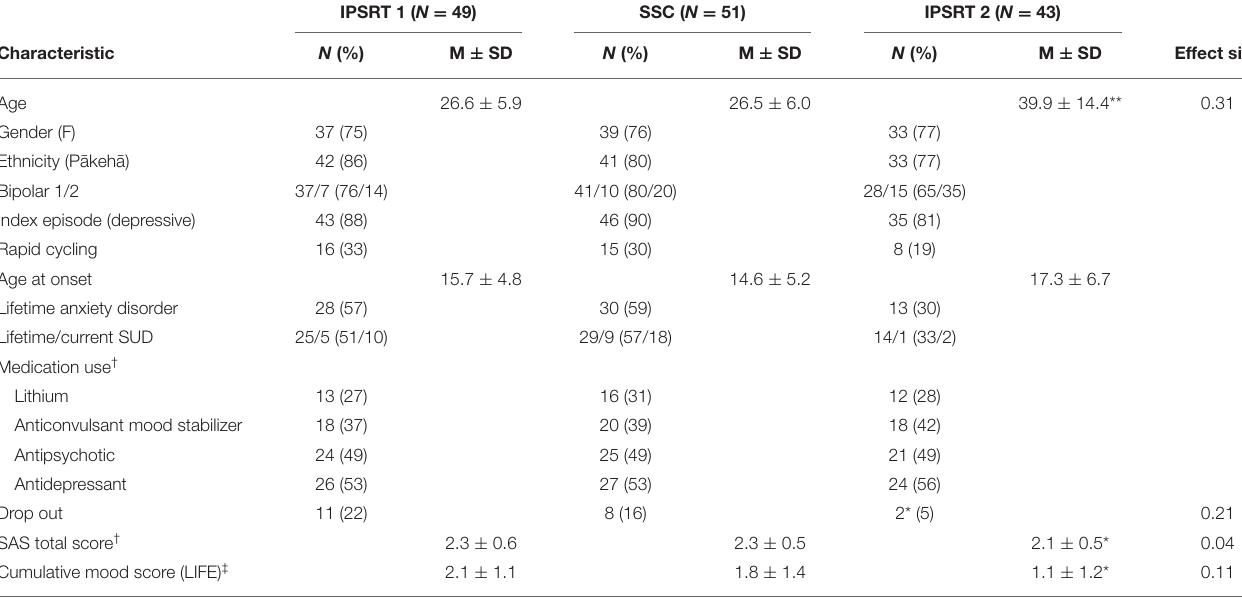
TABLE 2 | Clinical characteristics of study